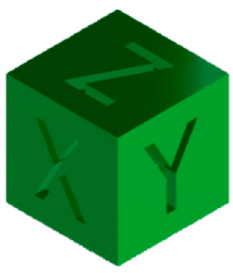
Figure 5. Computer aided design (CAD) model of XYZ Calibration Cube (with 20 mm sides) commonly used for determining acceptable acceleration and jerk speed limits of desktop 3D printers.